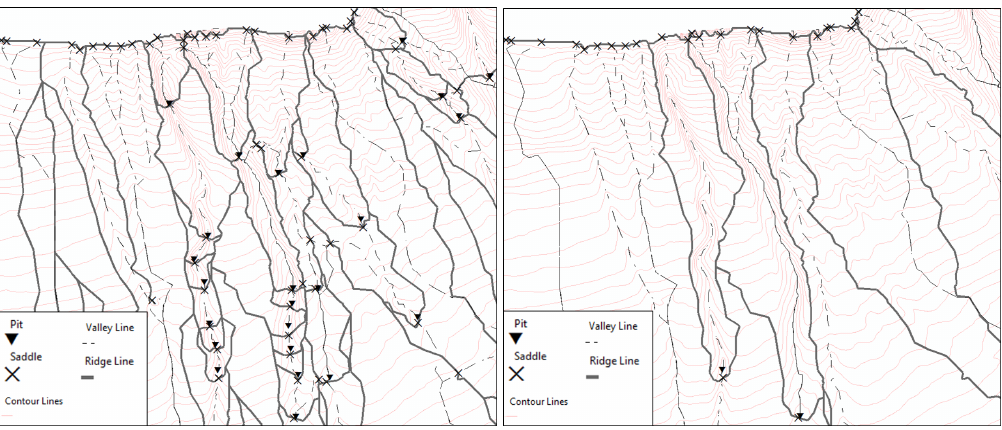
Figure 4. Left: surface network extracted from the DTM. Right: the network after simplification